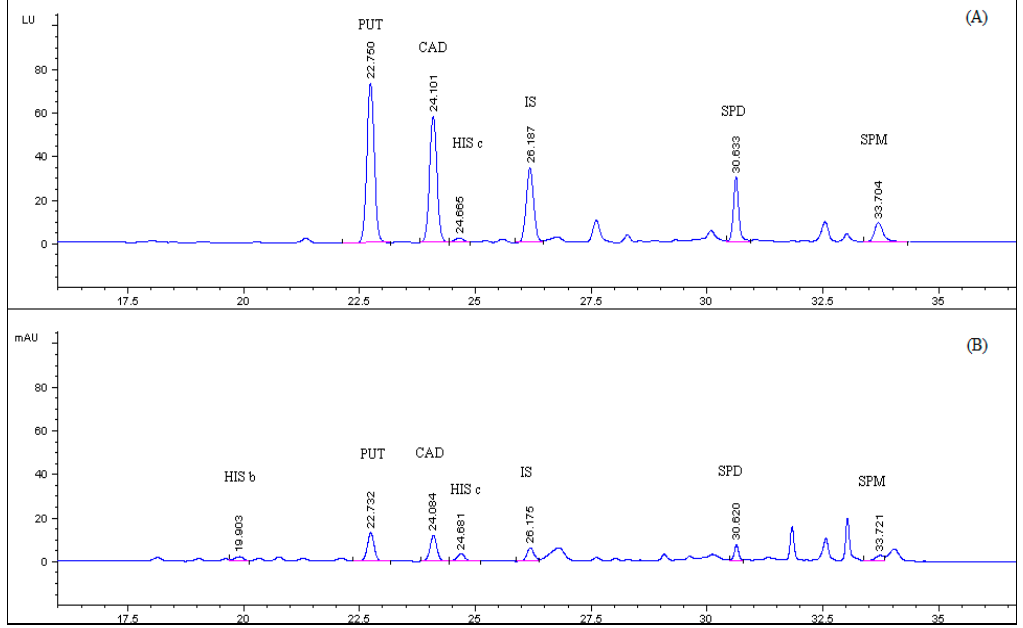
Figure 4. ( A ) HPLC-FLD; ( B ) HPLC-UV chromatogram of spiked sea bass tissue, fortified with putrescine (PUT), cadaverine (CAD), histamine (HIS), spermidine (SPD), spermine (SPM) at 8.0 mg kg − 1 and 1,7 diaminoheptane (IS) at 4.8 mg kg − 1 .